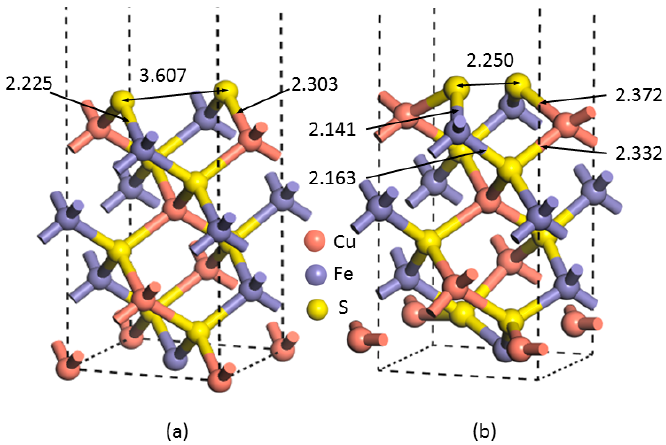
Figure 2. The chalcopyrite (001)-S surface: ( a ) unrelaxed and ( b ) relaxed. Distances in Angstroms. The most significant change observed is the distance between the two uppermost sulfur atoms; i.e., reduced from 3.607 Å at the unrelaxed lattice surface to 2.250 Å when reconstruction occurred, indicating that the (001)-S surface rearranged. In addition, the distance between the uppermost and